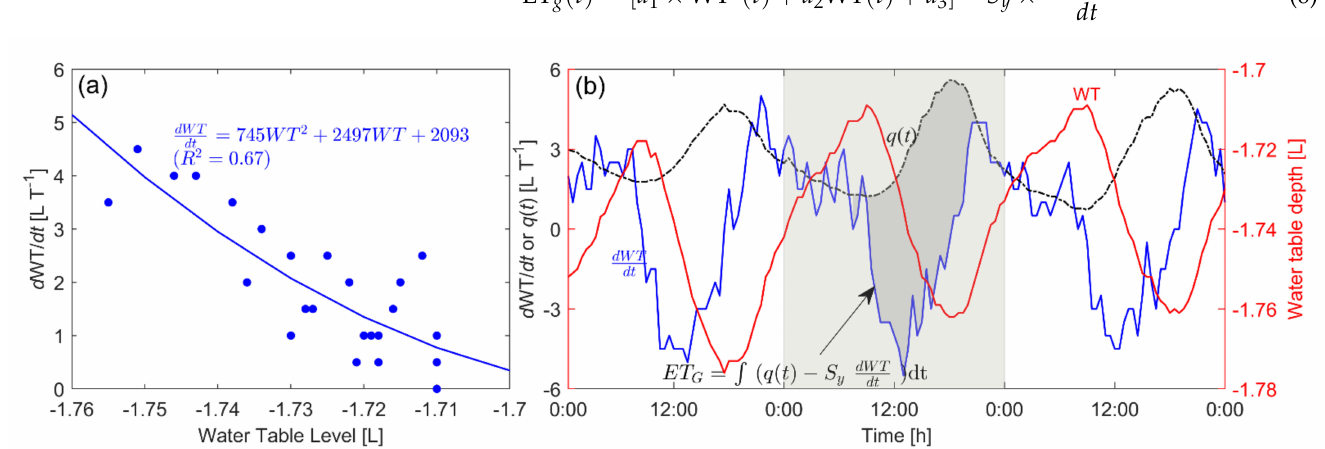
Figure 3. Illustration of the method proposed here for estimation of groundwater evapotranspiration based on water table fluctuation. ( a ) The rate of change in the water table dWT/dt as it changes with water table depth; the data show a quadratic relationship for the period of zero groundwater evapotranspiration; ( b ) diurnal variations in measured water table (WT) level (red line), calculated time-rate of change in measured water table level d WT/ dt (blue line), and the groundwater recovery rate q ( t ) (dash black line) estimates at the study site for a 3-day sample period (10–12 August 2017). The day under investigation is highlighted in gray. Note that the method proposed here operates at the sub-daily time scale and has to be aggregated to obtain daily values ET G (dark